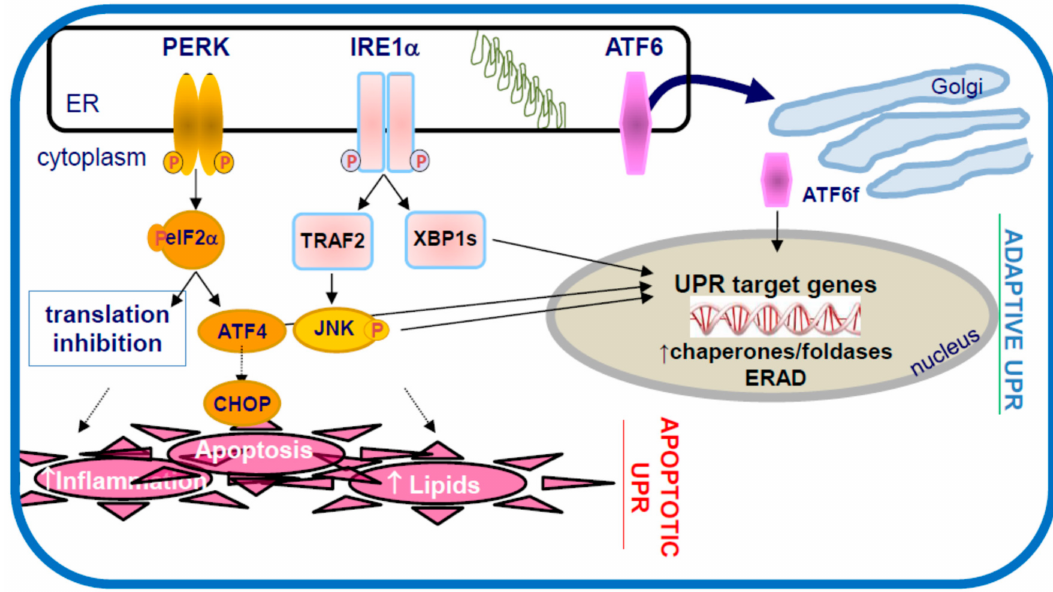
Figure 2. The unfolded protein response to ER stress. The accumulation of misfolded proteins in the endoplasmic reticulum, defined as ER stress, activates three ER transmembrane signaling factors PERK, IRE1 and ATF6, which initiate the unfolded protein response (UPR). Initially the adaptive UPR acts to reestablish ER homeostasis by decreasing protein flux into the ER (translation block), increasing the folding capacity of the ER (increased chaperone expression) and enhancing the ER associated protein degradation (ERAD) pathways. Chronic ER stress results in the activation of C/EBP homologous protein (CHOP) and the pro-apoptotic UPR, which can include pro-inflammatory responses and lipid accumulation—hallmark features of